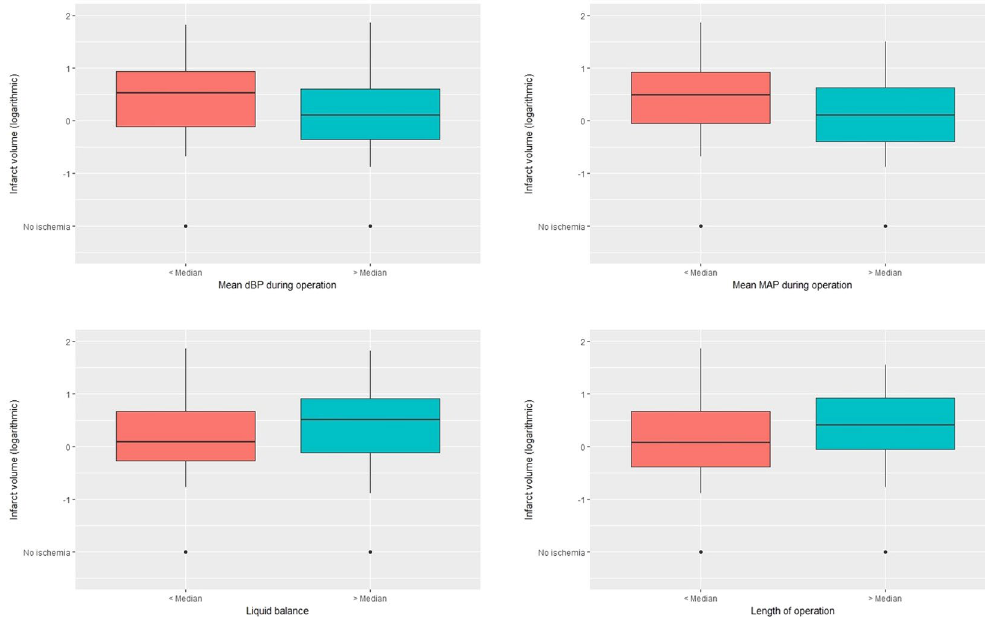
Figure 2. Box plot (dichotomized by the respective median) of mean intraoperative dBP, mean intraoperative MAP, liquid balance & length of surgery and infarct volume. Note that infarct volume (y axis) has been scaled logarithmically.